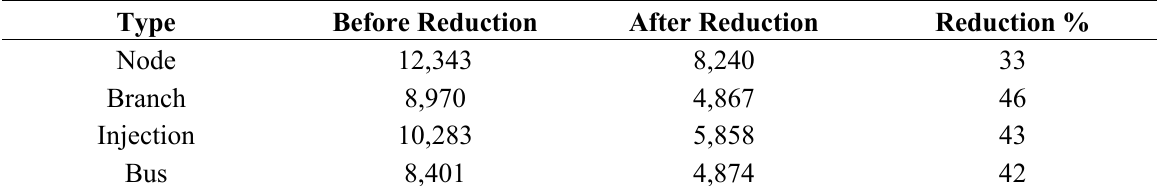
Table 5. Network reduction of test system.